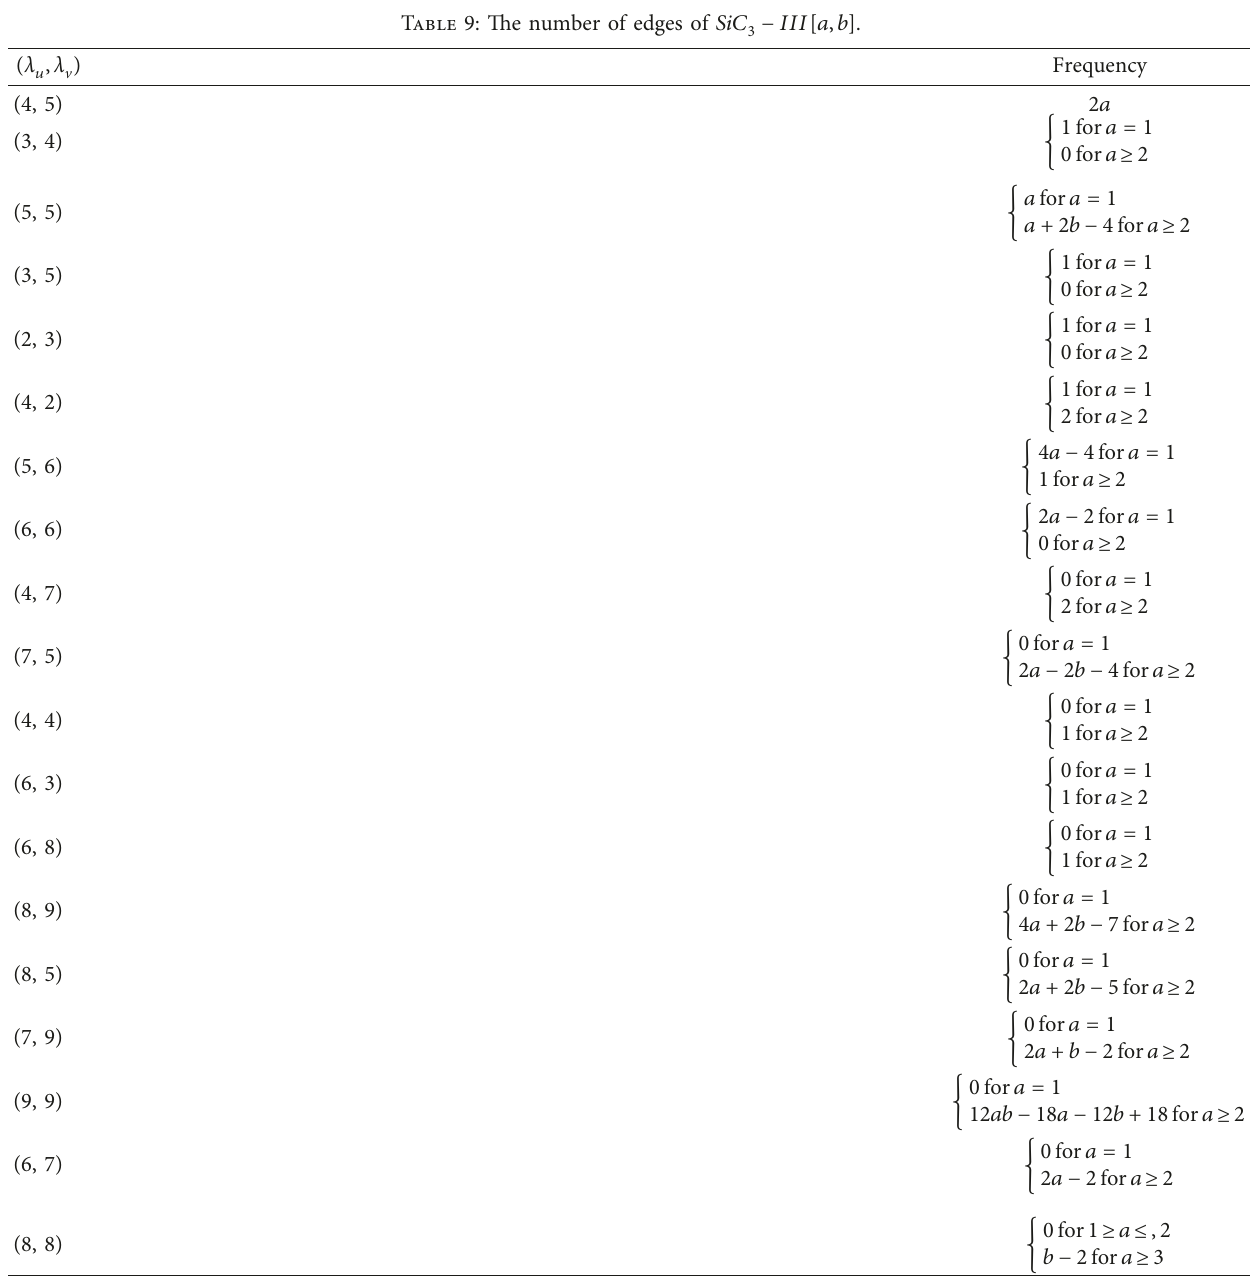
Table 9: The number of edges of SiC